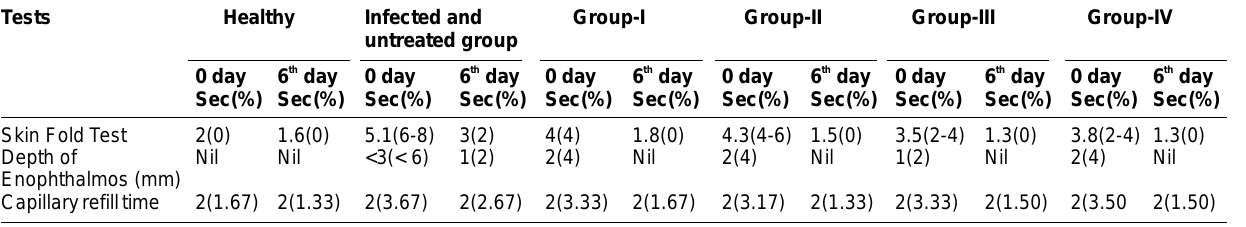
Table-1: Difference in Clinical signs before and after